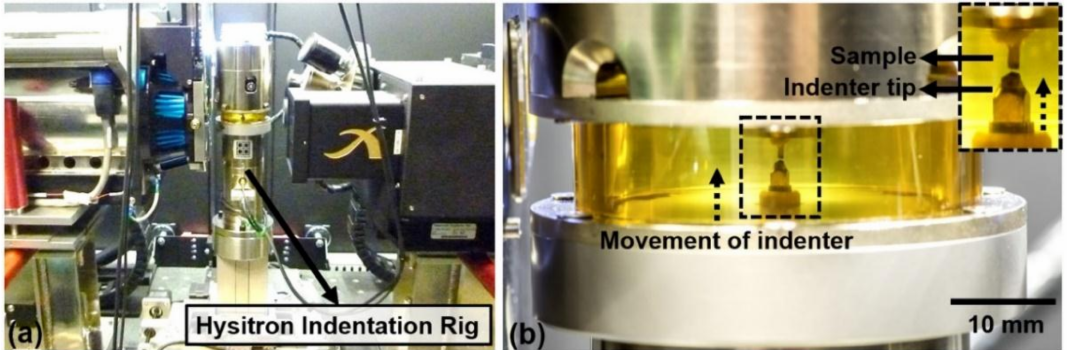
Figure 2. ( a ) The Hysitron indentation rig mounted within the Zeiss-Xradia VersaXRM-520 system during initial specimen alignment, ( b ) Magnified image showing the indentation tip